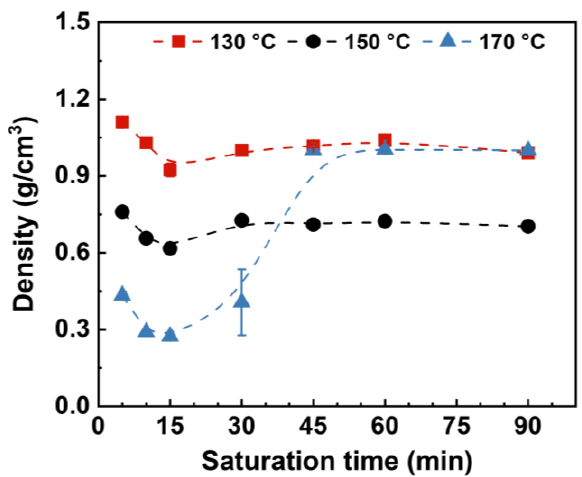
Figure 8. Density of HD-TPU foams as the function of saturation time. The saturation pressure was 15 MPa.